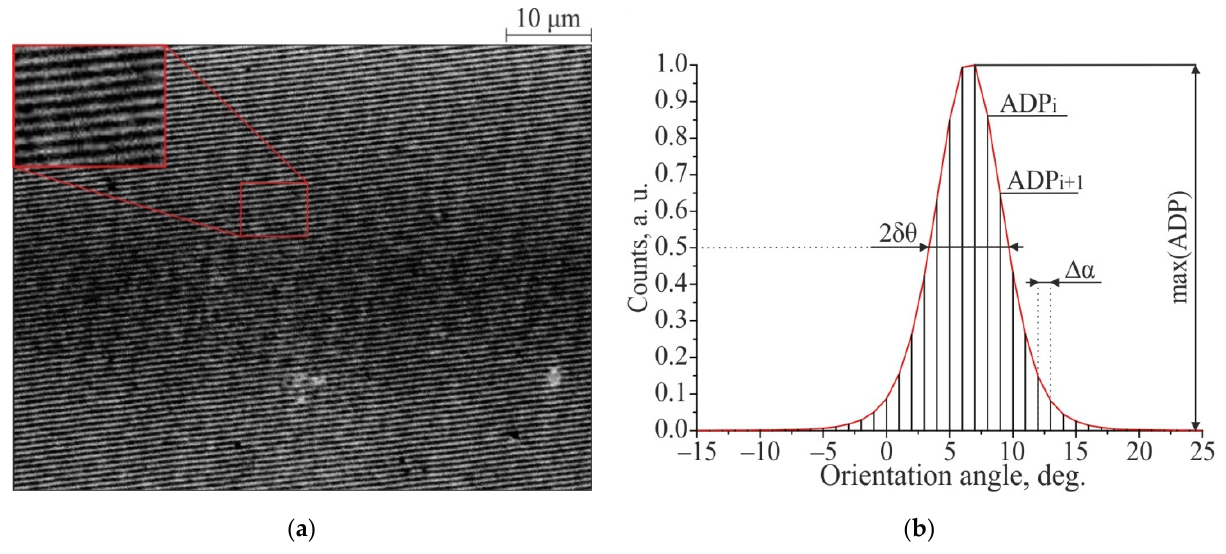
Figure 3. Determination of the regularity of the TLIPSS formed at a laser power of 250 mW and a scanning speed of 500 μ m/s: a fragment of the original SEM image ( a ); angular pixels distribution (ADP) graph ( ∆ α = 1°) ( b ).